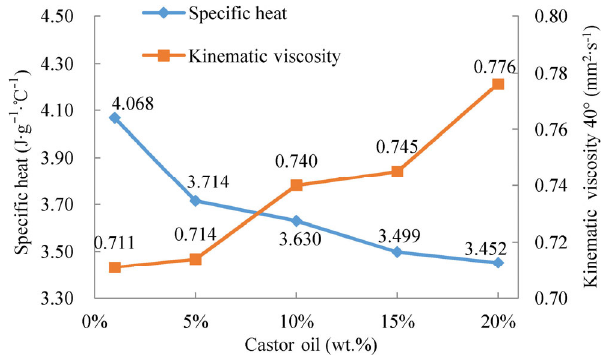
Fig. 7 Variation in the specific heat and kinematic viscosity of the W-O cutting fluids at 40 °C.